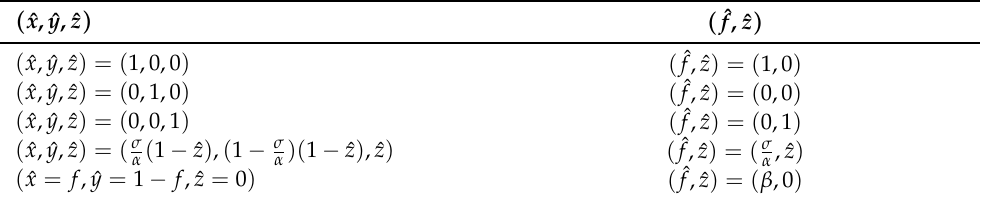
Table 1. Equilibrium points relationship between ( ˆ x , ˆ y , ˆ z ) and ( ˆ f , ˆ z ) . α = ( r r ) / ( r ( N β = ( N 1 ) d ) − −